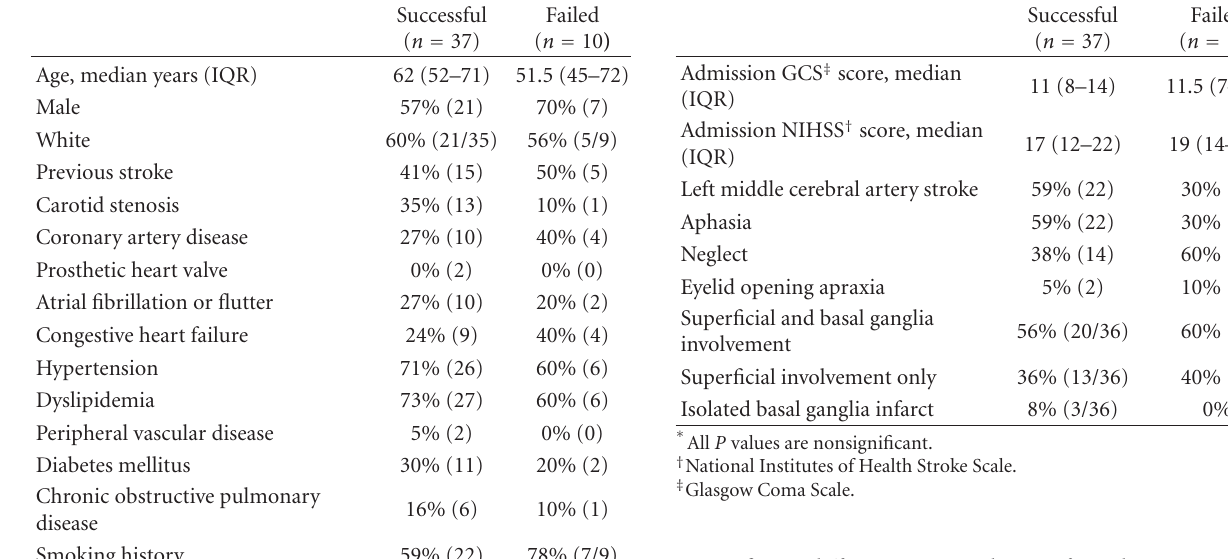
Table 1: Baseline characteristics of middle cerebral artery acute ischemic stroke patients in whom extubation was successful versus failed ∗ .